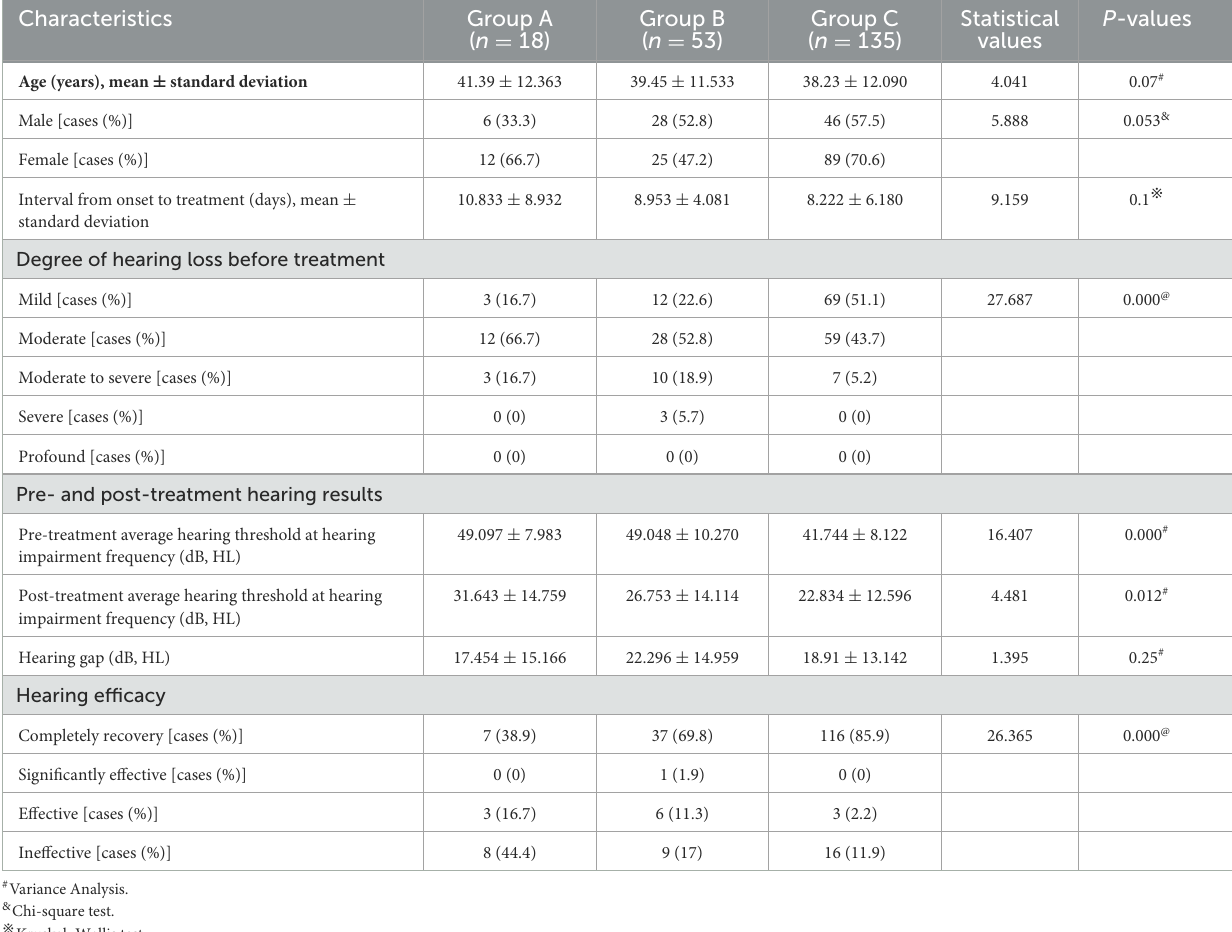
P -values Group B Group C Statistical ( n = 18) ( n = 53) ( n = 135) values